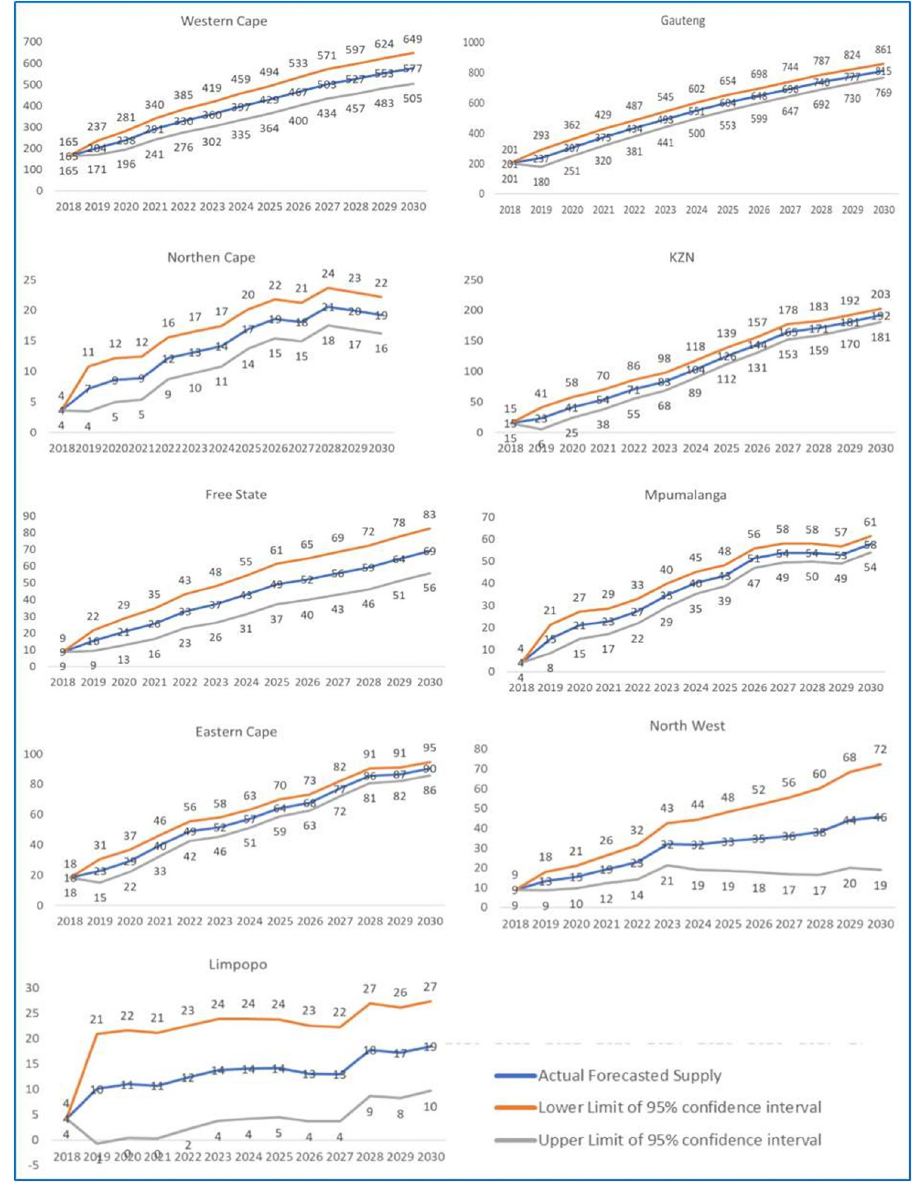
Fig 3. Forecasted province-wide shortage of dentists for SA (up to 2030).